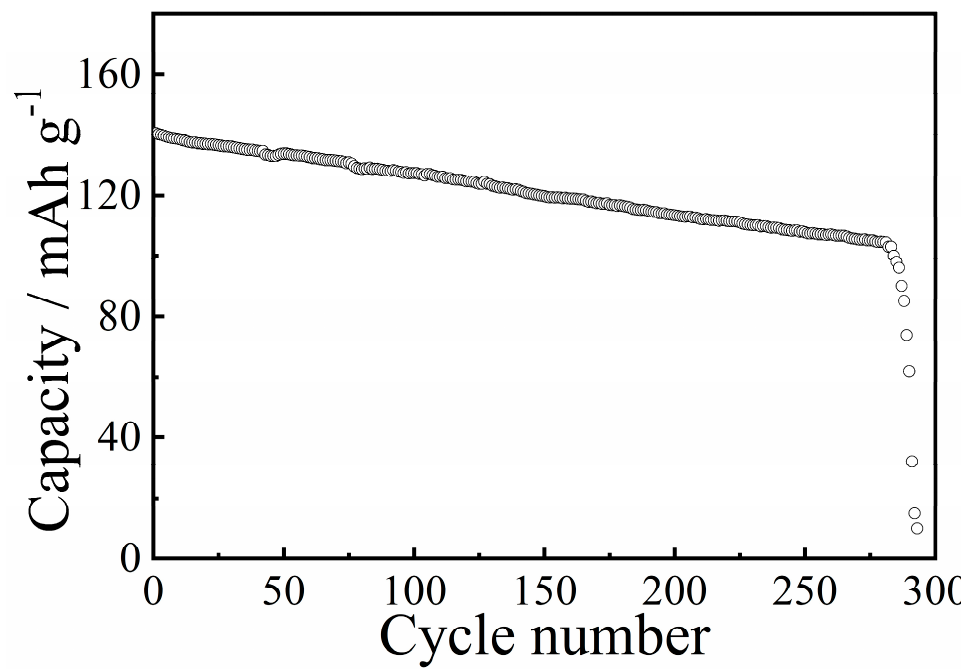
Figure 9. The long-term cycling performance of the GE-based LFP/GE/Li solid-state cell at 0.5C and Figure 9. The long ‐ term cycling performance of the GE ‐ based LFP/GE/Li solid ‐ state cell at 0.5C and 25 ◦ 25 °C.